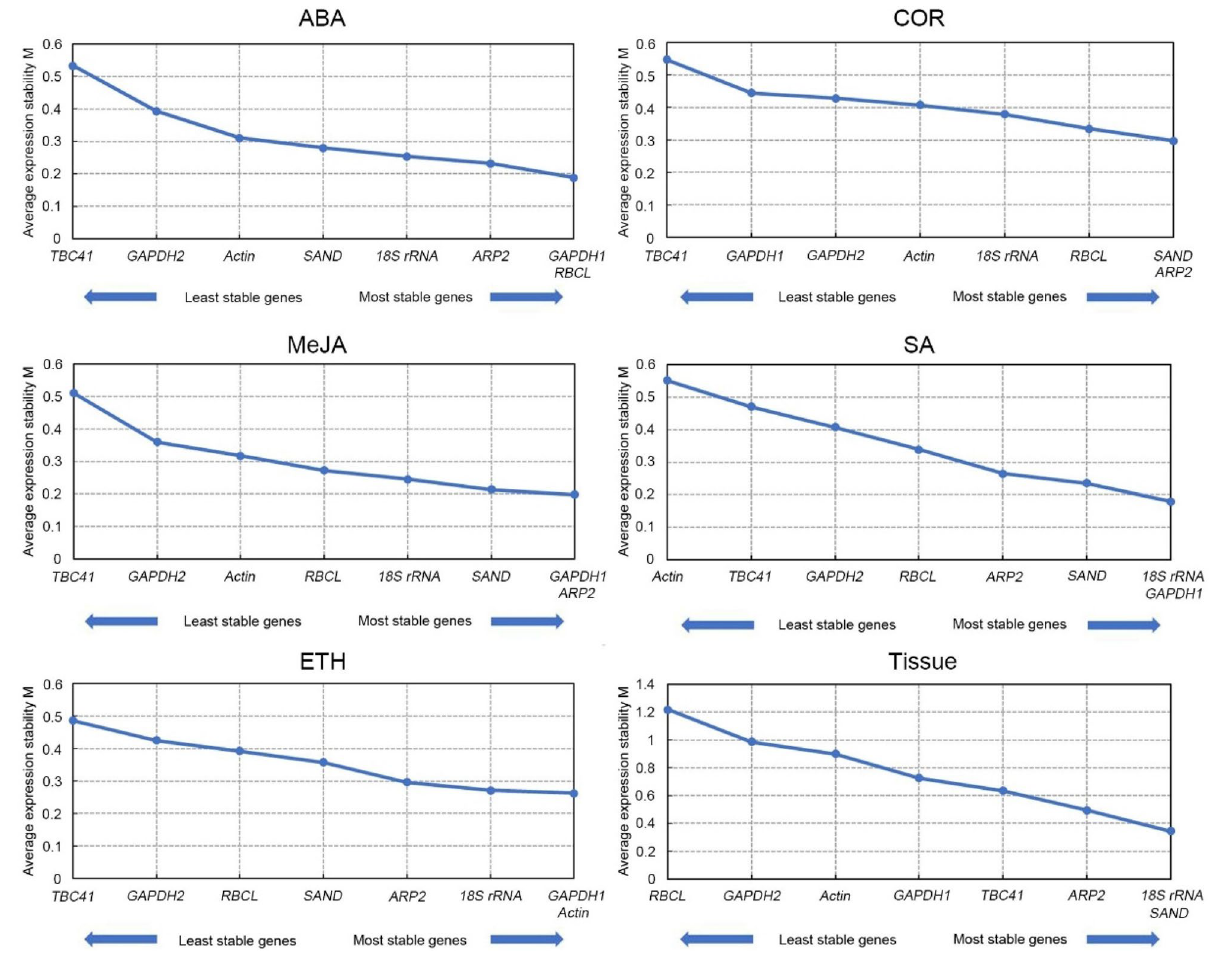
Figure 3. Gene expression stability and ranking of eight reference genes under different treatments and tissues based on geNorm. Expression stability value (M) for each reference gene was obtained and graphed. ABA, abscisic acid; COR, coronatine; MeJA, methyl jasmonate; SA, salicylic acid; ETH, ethylene. The figures were generated by geNorm (version 3.4; http://medge n.ugent .be/~jvdes omp/genor m/).